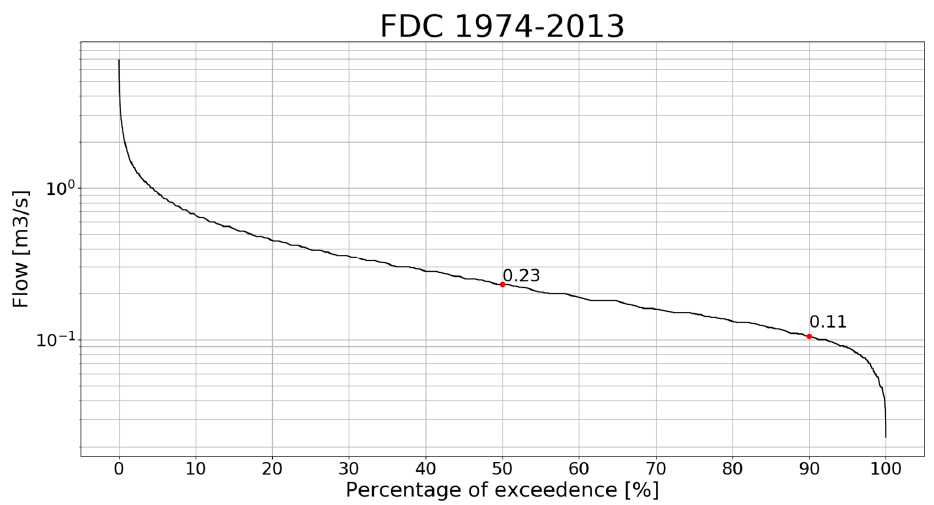
Figure 6. Flow duration curve (FDC) with Q90 and Q50 marked with red points. Based on daily flow data from the HLNUG [32].